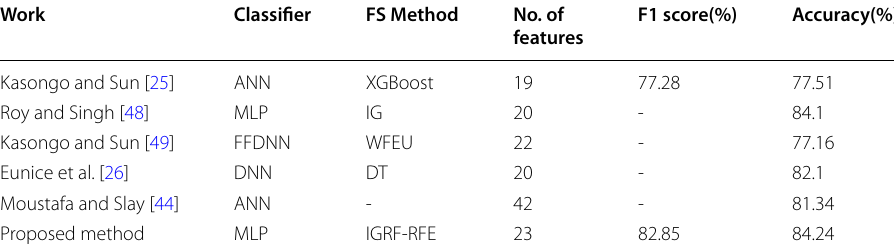
Table 9 Comparison results of other methods on UNSW‑NB15 dataset Work Classifier